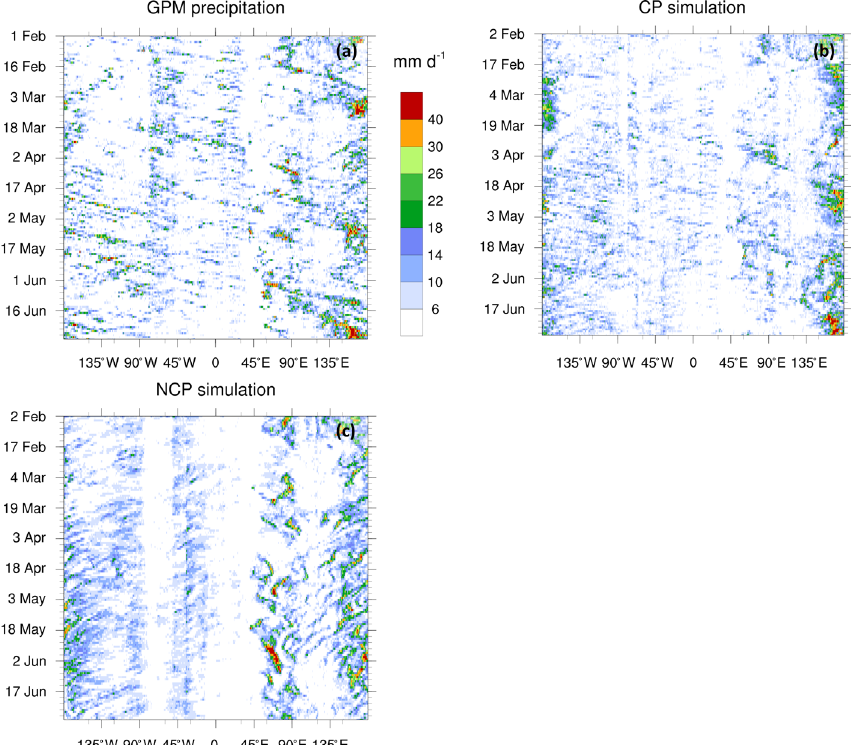
Figure 2. Time–longitude cross section of the simulated precipitation per day (mm) for the region between 10 ◦ S and 10 ◦ N. (a) displays the GPM precipitation, (b) denotes the CP simulation, and (c) denotes the NCP simulation. The colour bar applies to all